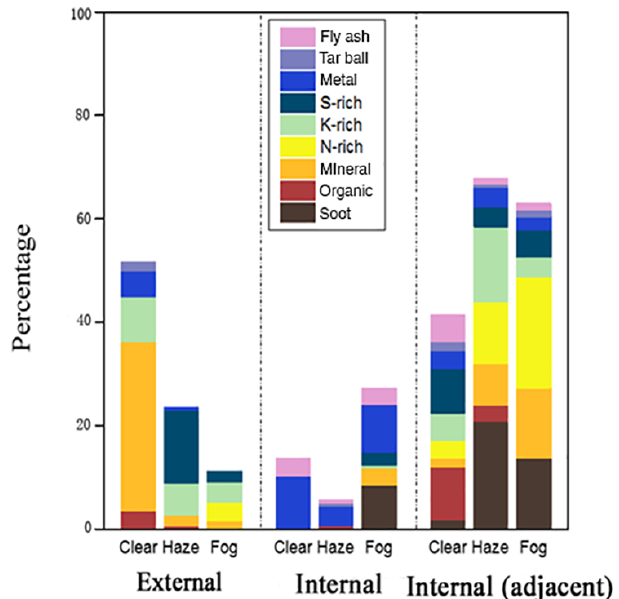
Figure 5. Percentages of nine particle components under clear, haze and fog conditions with different mixing